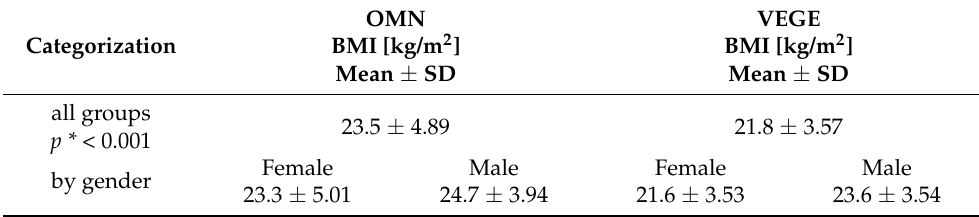
Table 6. The classification of the studied groups concerning the BMI index. BMI Classification p < 0.001 * 2 Underweight (<18.5 kg/m 2 ) Normal weight (18.5 to <25.0 kg/m 2